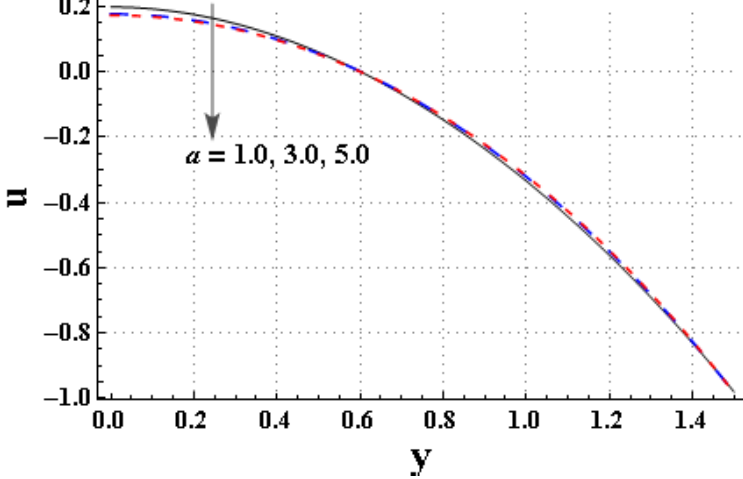
a , on velocity u . Figure 2. Effect of non-Newtonian fluid coefficient,